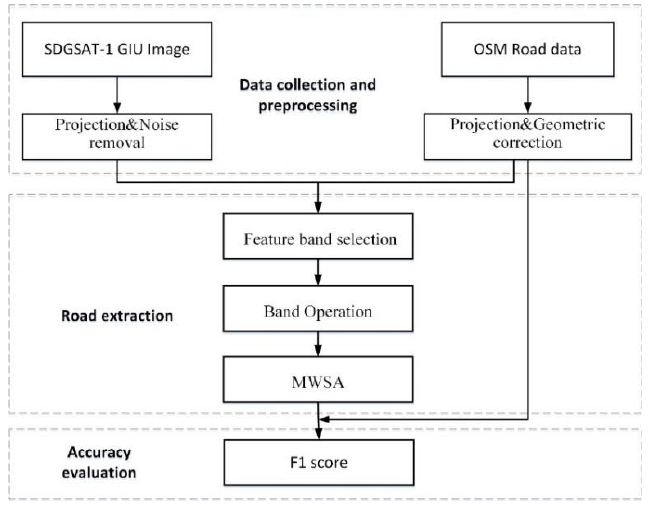
Figure 2. Flowchart of the BO-MWSA method.